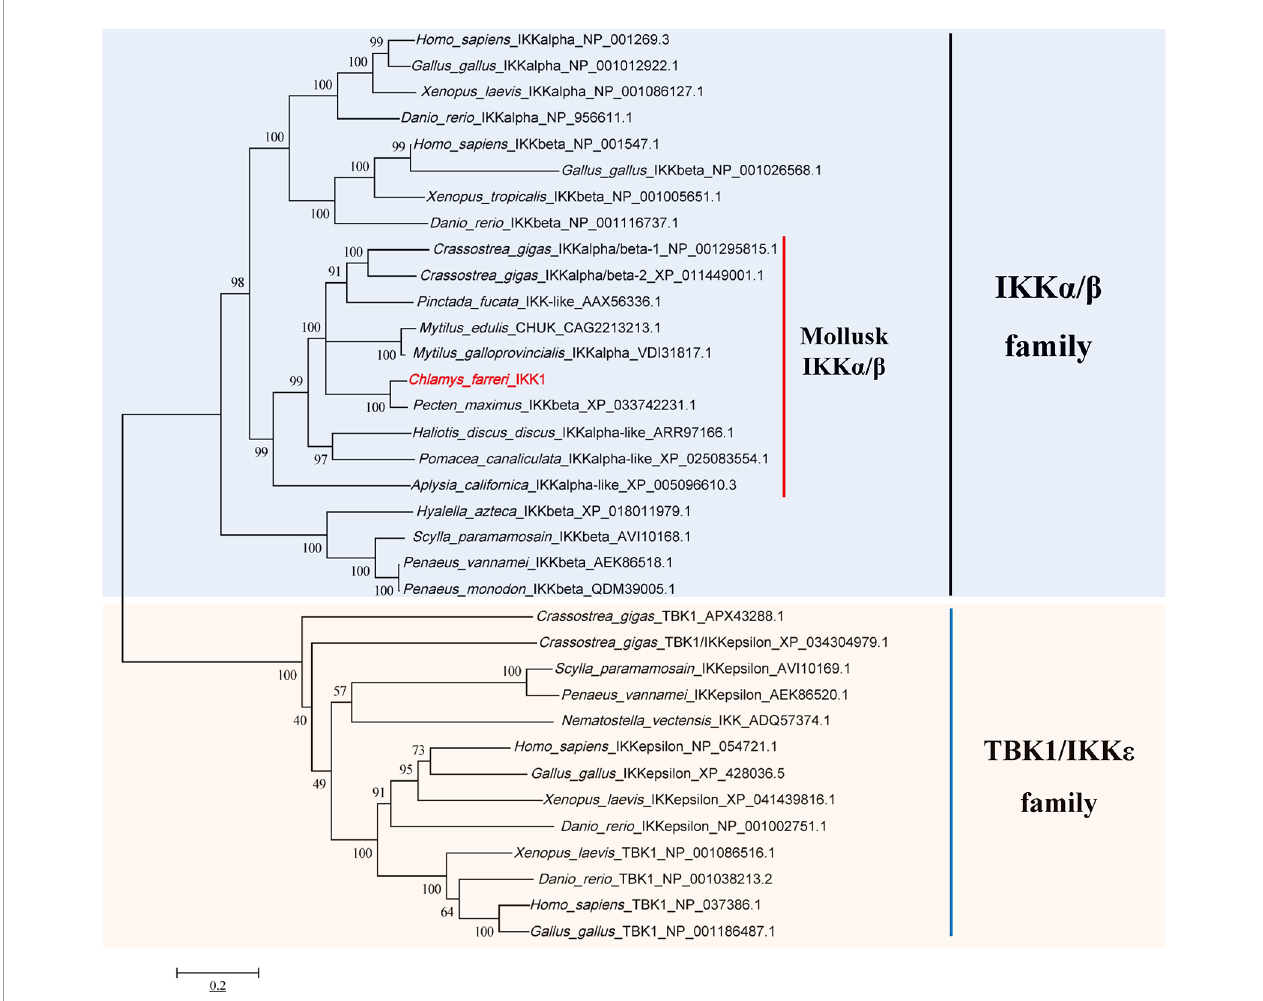
FIGURE 2 | Phylogenetic tree of IKKs and IKK-related kinases from various species. The tree was constructed using the neighbor-joining method with 1000 bootstrap replications. The tree is divided into two main branches: IKK a /IKK b family members are in the light blue section, and TBK1/IKK ϵ family members are in the light brown section. The GenBank accession numbers of the protein sequences are also